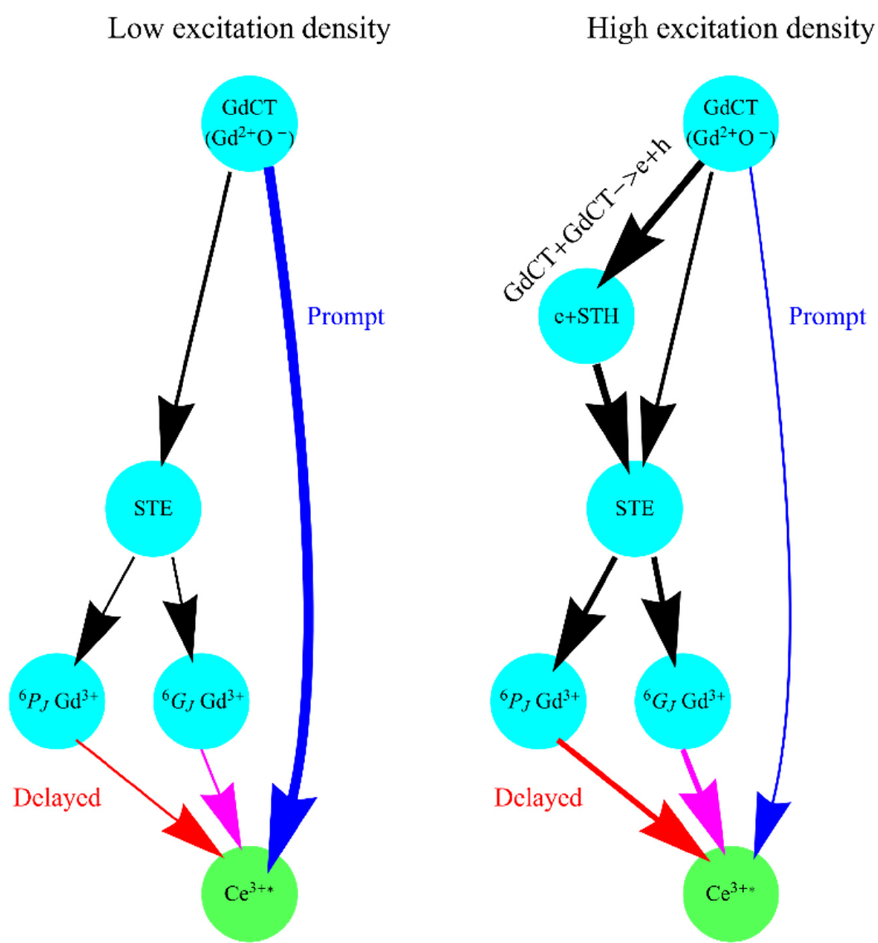
Figure 7. Scheme of the energy transfer pass-ways from the excitons to Ce 3+ emission centers in GAGG:Ce in case of low (at left ) and high (at right ) excitation densities. GdCT—Gd charge transfer exciton; STE—self-trapped exciton; STH—self-trapped hole, Ce 3+* - excited cerium ion.